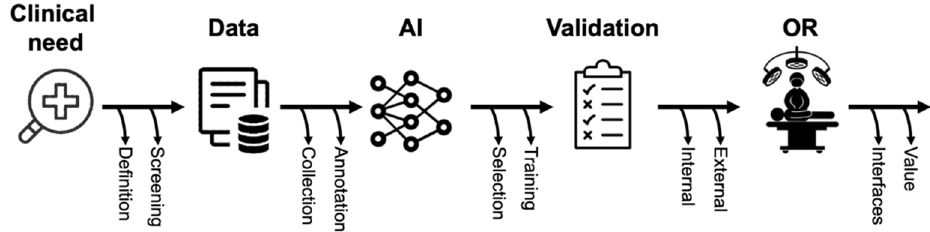
Figure 1. Schematic representation of the phases of surgical AI research.